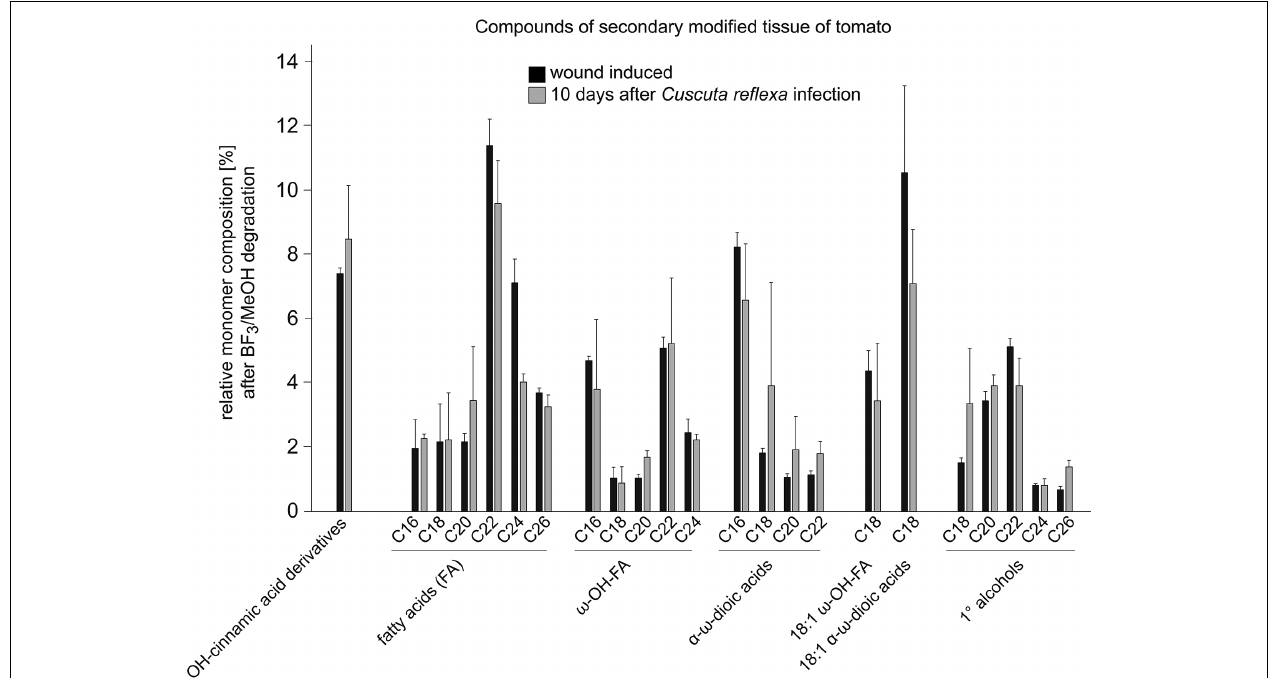
FIGURE 3 | Relative monomer composition of the secondarily modified tomato tissue. The constituents were isolated from tomato shoot tissue infected with C. reflexa for ∼ 10 days (for example see Figure 2C ).Tissue was treated and degraded by BF 3 -methanolysis as described (Supplementary information, Leide etal., 2012) and analyzed via gas chromatography followed